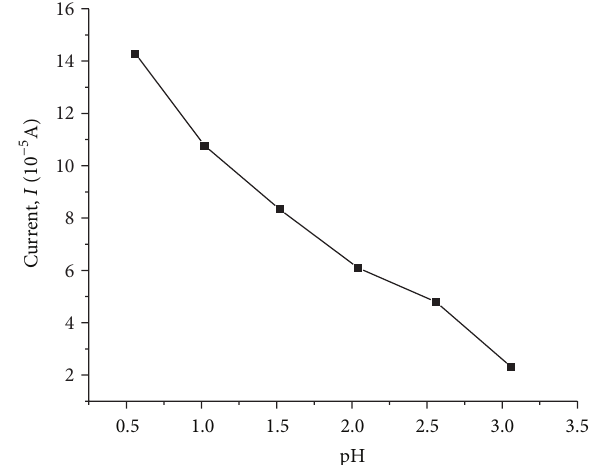
Figure 4: Effect of pH on the anodic peak current of 1mM caffeine.